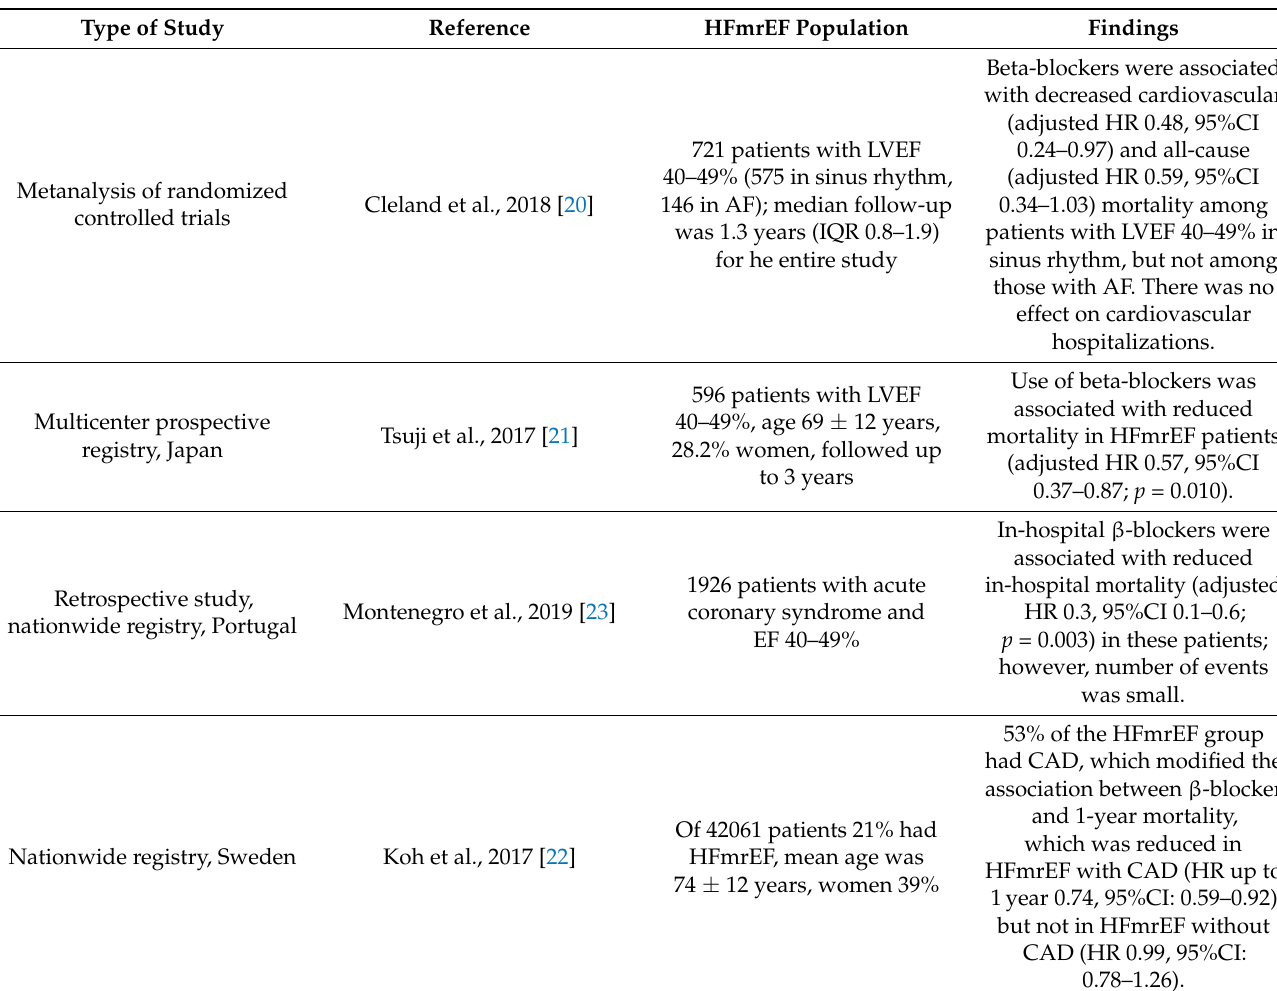
Table 1. Key Studies with β -Blockers in Patients with heart failure (HF) with mid-range ejection fraction